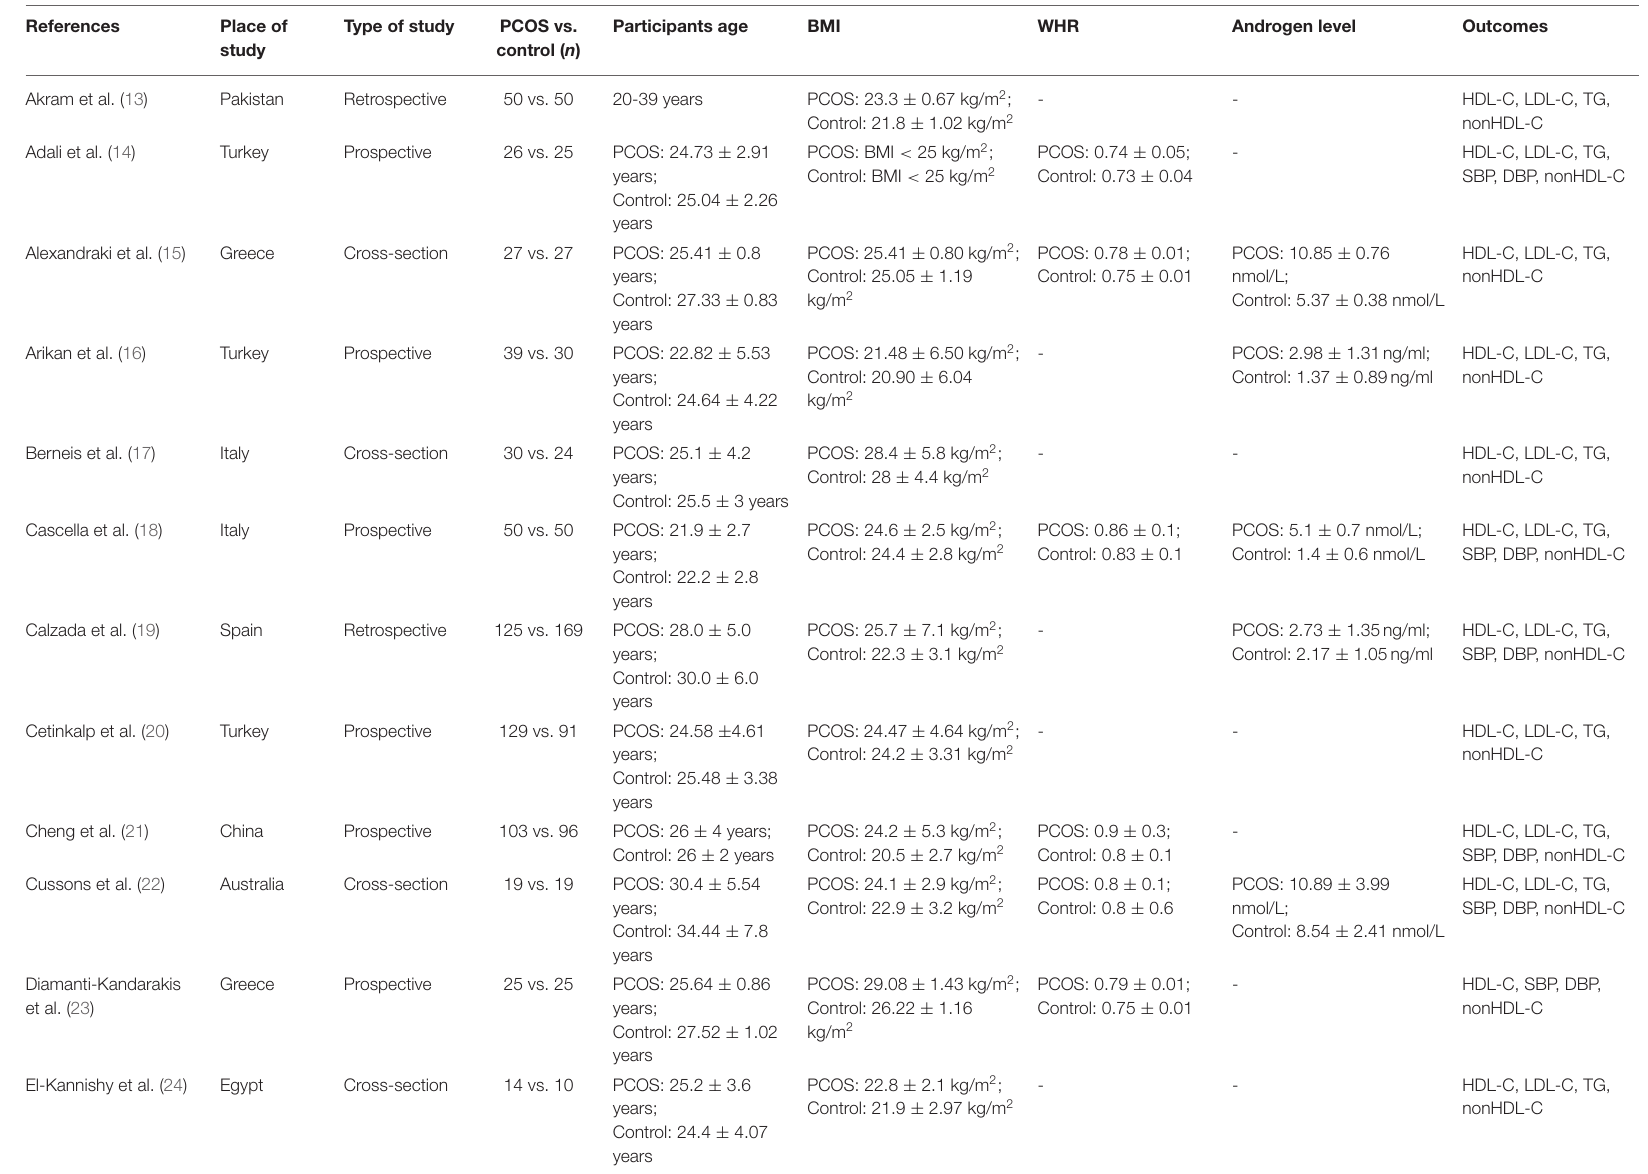
TABLE 2 | Characteristics of included studies in the